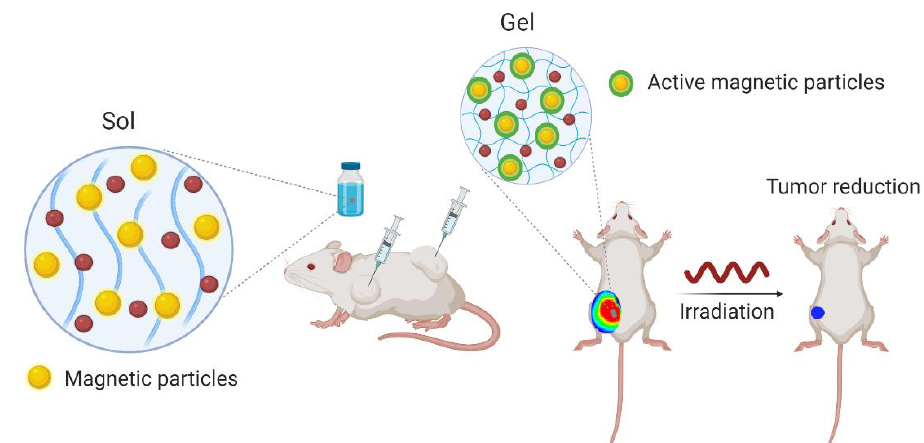
Figure 4. Schematic representation of magnetic-responsive hydrogels. They incorporate nanoparticles, which under a magnetic field vibrate due to their paramagnetic properties. A temperature increase is induced triggering drug release. The red circles represent the drugs loaded in the hydrogels. Created with BioRender.com (accessed on 15 January 2021).